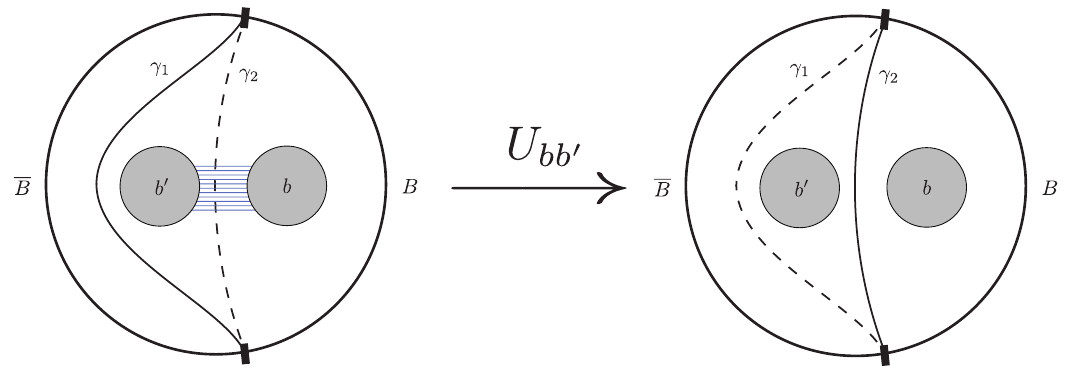
Figure 4: An AdS / CFT setup in which a unitary acting within an entanglement wedge changes the location of the quantum minimal surface. On the left, we have two black holes in an entangled pure state. Because of the large amount of entanglement, γ quantum minimal and therefore both black holes are inside the entanglement wedge of B . On the right, we have the situation after acting on both black holes with a that maps the original state to a factorized pure state. Now γ unitary U bb (cid:48) minimal. This unitary has changed the entropies S ( B ) and S ( B ) and therefore cannot be represented by a unitary on B